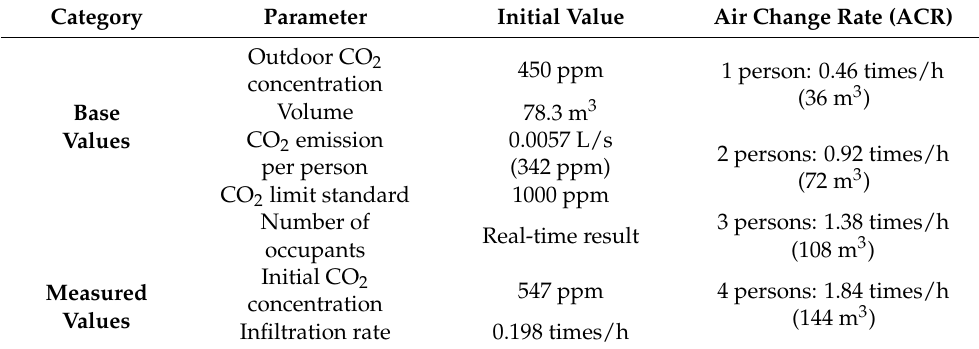
Table 7. Initial values for the ventilation